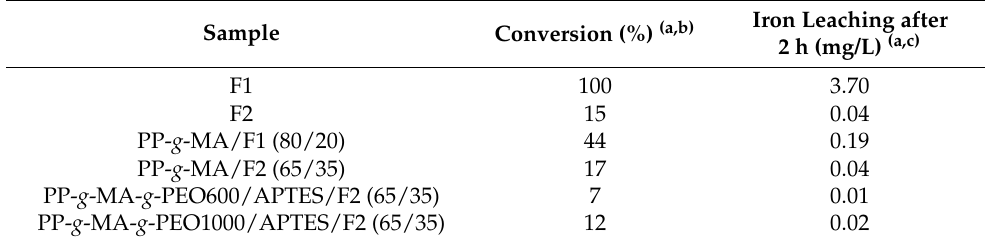
Table 6. Conversion of phenol in the Fenton processes catalyzed by the Fenton catalyst F2 and the Fenton polymer composites compared to the iron leaching after 2 h degradation.